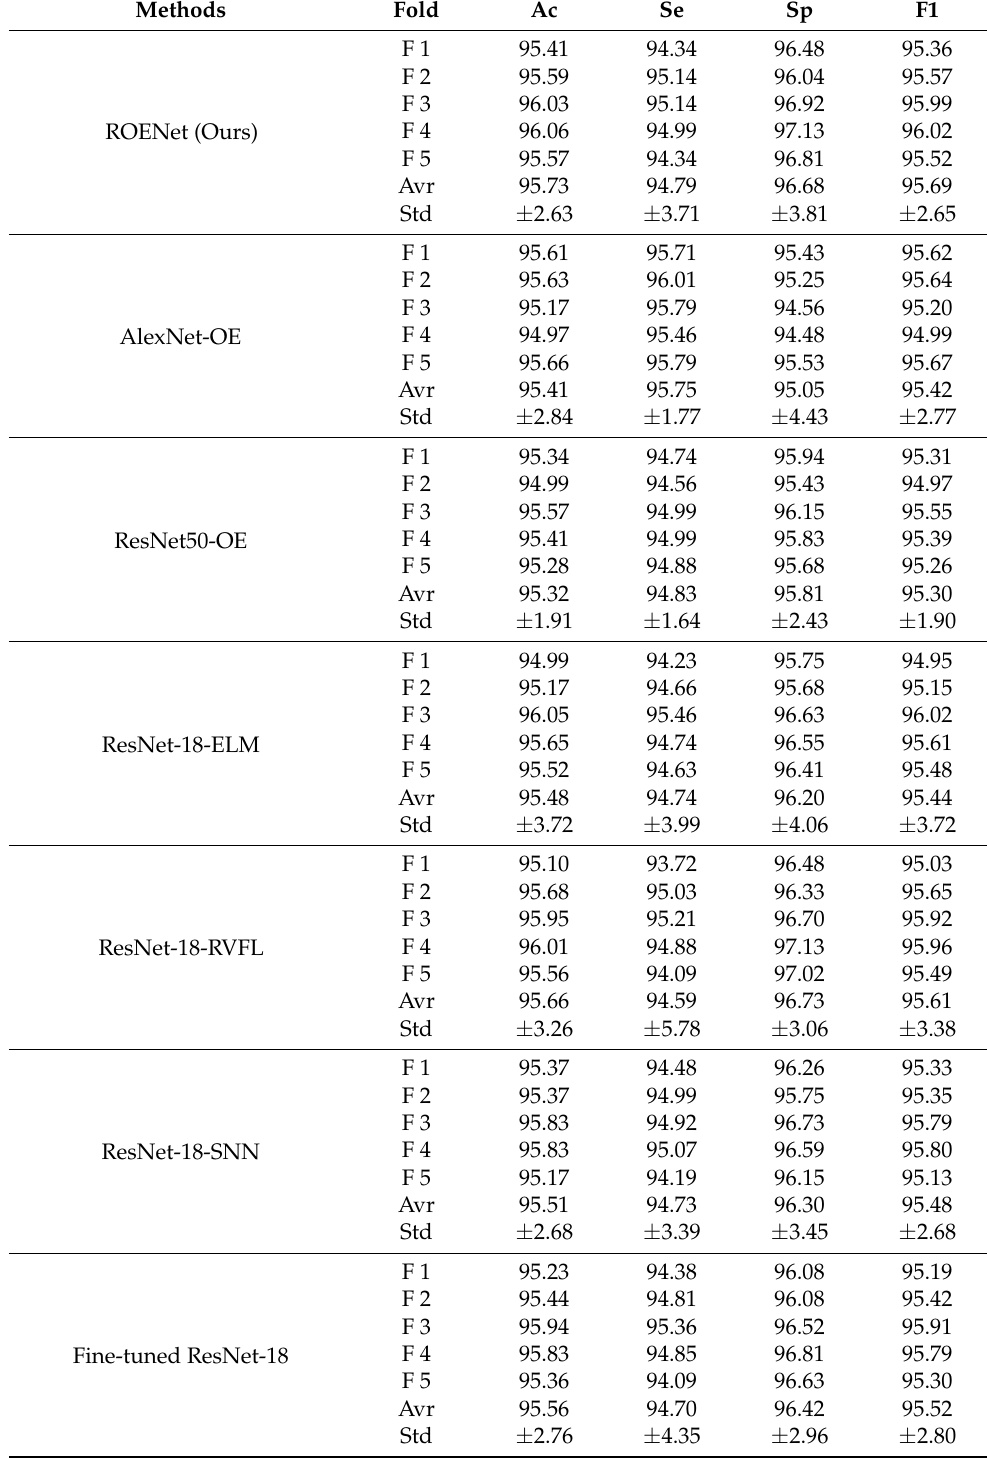
Table 4. The classification